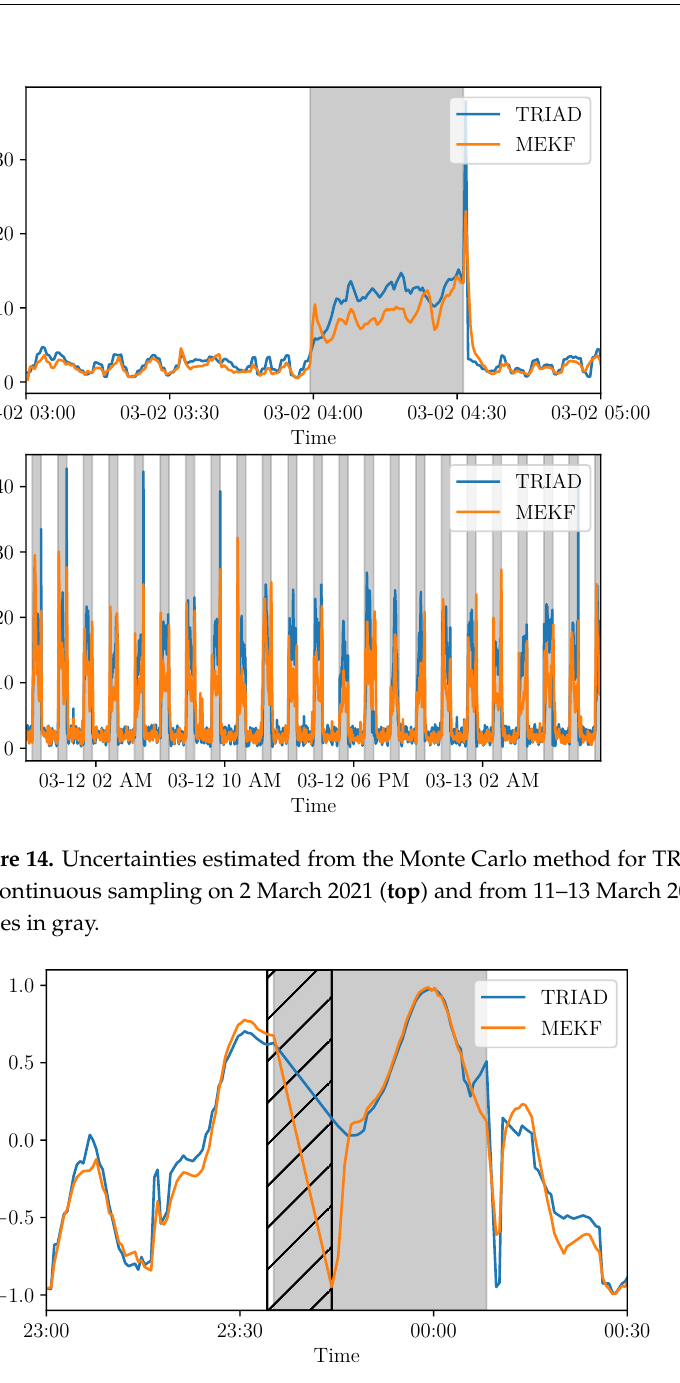
Figure 15. Nadir Z component in the satellite frame based on the TRIAD and MEKF methods— missing values are delimited with hatches for a 10 min duration on 3 February